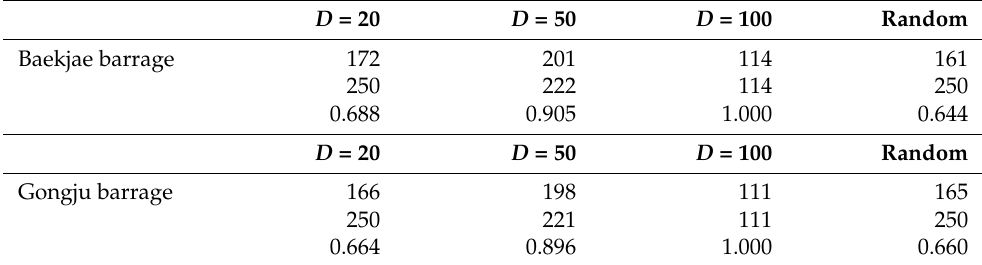
Figure 9. Accuracy CDF of Keum River: Baekjae barrage ( left ) and Gongju barrage ( right ). Table 4. Achieved accuracy ratio of Kuem River ( > = 80 total percentage).